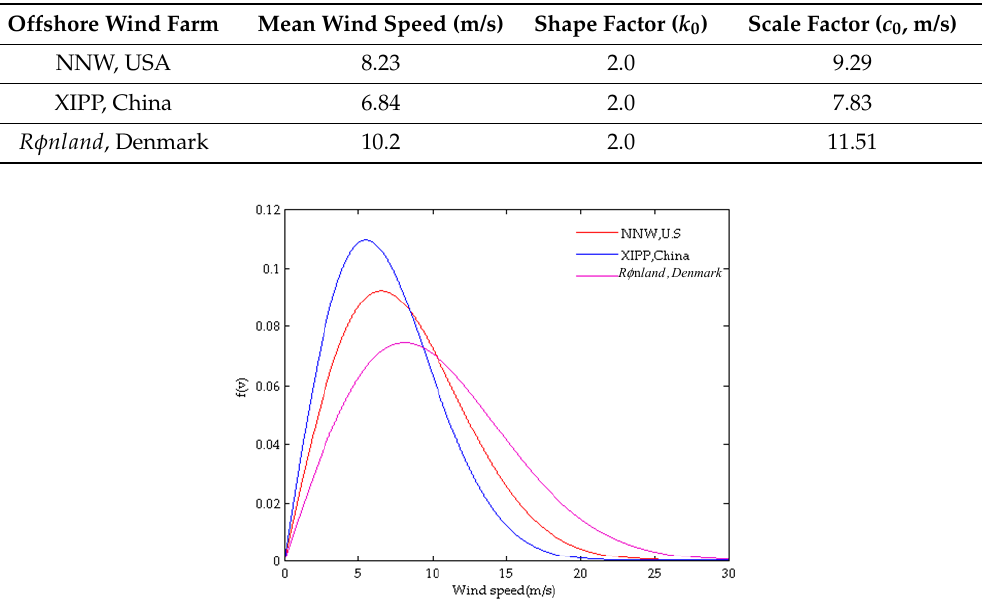
Table 2. Wind statistic data of three offshore wind farms.